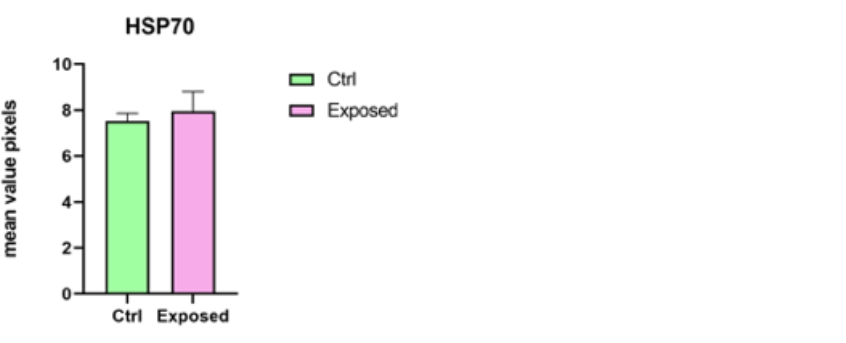
Figure 8. Statistical analysis for HSP70 biomarker between the control group and larvae exposed to 27 GHz (no statistically significant difference was found at p < 0.05).